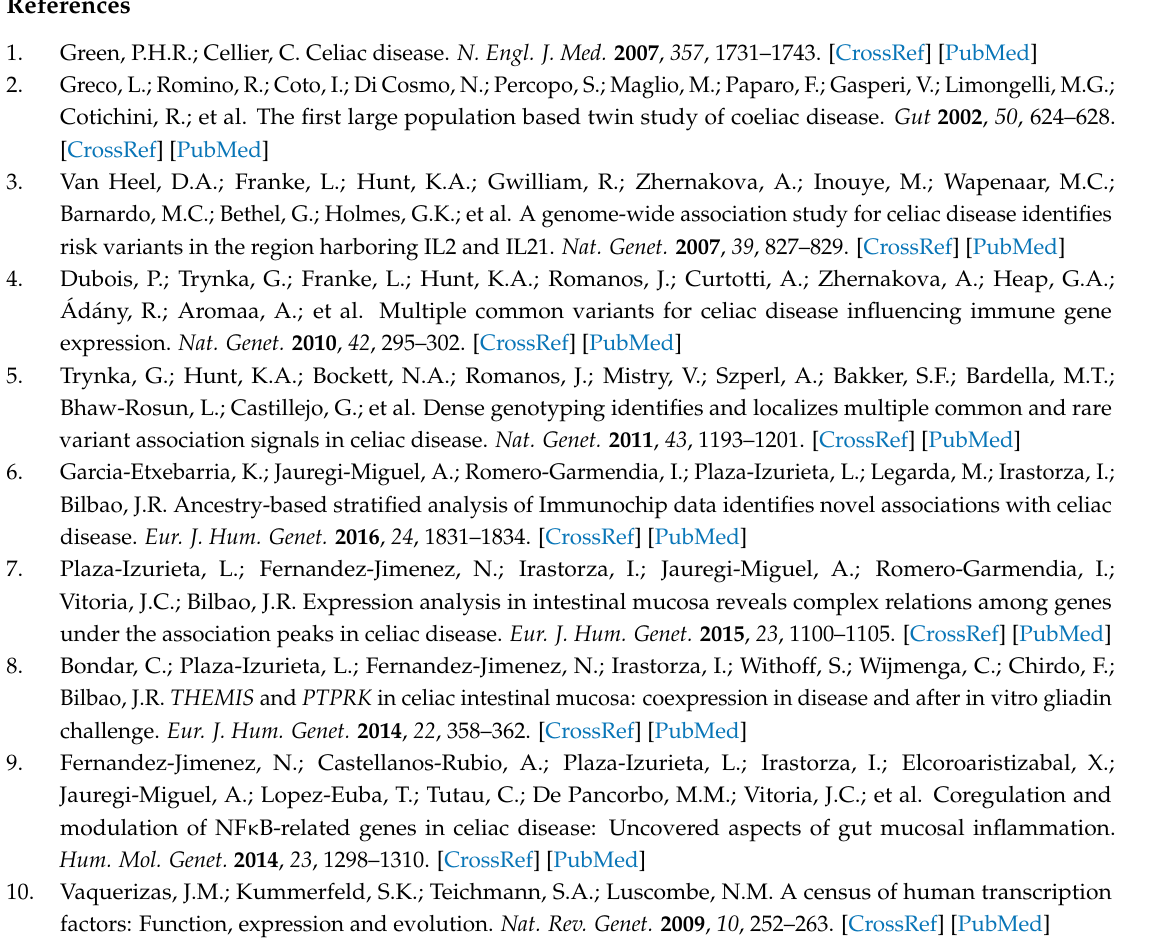
Figure S1: Flowchart of the methodology used for the microarray and bioinformatics analyses; Figure S2: (A) Co-expression pattern changes of DCGs with enrichment for HOXA5 binding sites, from basal CD to gliadin-challenged CD; (B) Co-expression pattern changes of DCGs with enrichment for IRF1, HOXA5 and NFKB1 binding sites, from gliadin-challenged CD to basal CD. Each small square represents the p value for the correlation of the expression level in a specific gene pair. Red-blue scale represents positive to negative Spearman correlation. Below, the top 10 GO term annotations for those DCGs with respect to the genome; Table S1: TaqMan assays for expression analysis; Table S2: Gene expression data for the genes co-expressed in the Magenta module (tissue-culture experiment). B = biopsies in basal conditions; G = gliadin-stimulated biopsies. Table S3: Gene expression data for the genes co-expressed in the Purple module (tissue-culture experiment). B = biopsies in basal conditions; G = gliadin-stimulated biopsies. Table S4: Gene expression data for the genes co-expressed in the Brown module (long-term experiment). T = treated, inactive CD patients; D = CD patients at